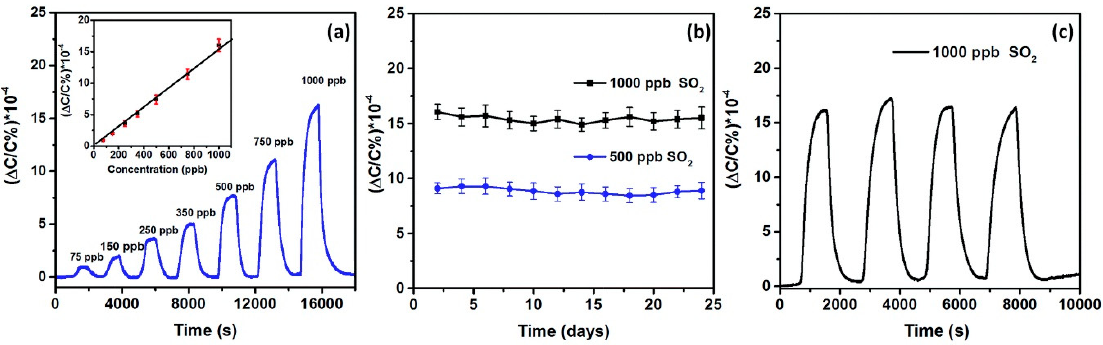
Figure 2. ( a ) Detection of SO 2 in the 75 to 1000 ppb concentration range ( b ) linear response for MFM-300 (In) MOF-sensor upon exposure to SO 2 for a 24-day ( c ) reproducibility cycles for the detection. Reproduced and adapted from Ref. [12]; Copyright (2018), RSC Journal of Materials Chemistry A.